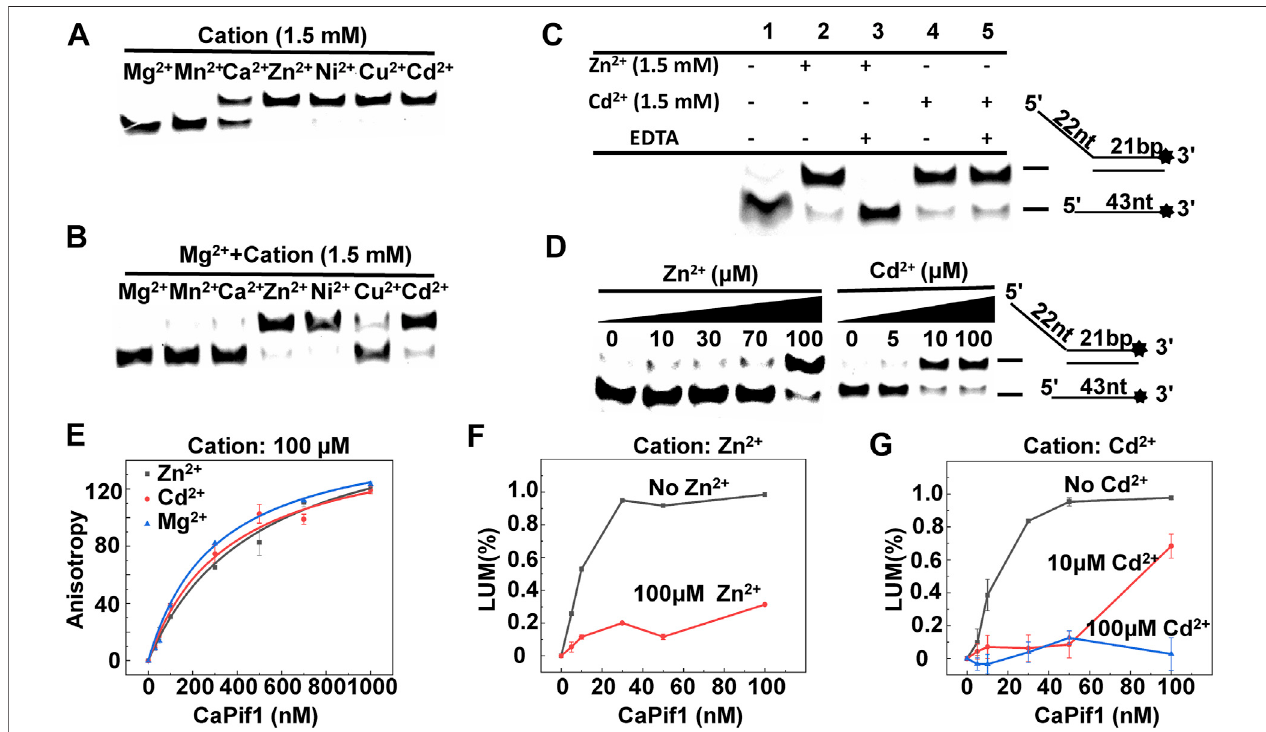
FIGURE 5 | The effects of metals on the unwinding activity of CaPif1. (A) CaPif1 (25 nM) was reacted with the DNA OhS22D21 (10 nM) in the presence of the indicateddivalentmetal(1.5 mM). (B) CaPif1wasincubatedwithindicateddivalentmetal(1.5 mM)andthenthesameconcentrationofMgCl 2 wasaddedseparately. (C) Lane 1: The control group containing 1.5 mM Mg 2+ without Zn 2+ and Cd 2+ ; Lane 2 and Lane 4: same method ( Figure 5B ); Lane 3 and Lane 5: CaPif1 separately incubated withZn 2+ (1.5 mM)orCd 2+ (1.5 mM)at 30 ° Cfor5 min, thenaddMgCl 2 witha fi nalconcentrationof1.5mM, incubate againat thesametemperaturefor 5 min, and fi nally add the 5 mM ofATPto startthe unwinding reaction. (D) Inhibit theunwinding activity of CaPif1at low concentrationsZn 2+ or Cd 2+ . Atotal of10 nM of fl uorescently labeled DNA substrate (OhS22D21)wastitratedwithincreasingconcentrationsofZn 2+ orCd 2+ .More details aredescribedinthe “ Materials and Methods ” section. (E) Polarizedlightisusedtodetectthein fl uenceofZn 2+ ,Mg 2+ ,andCd 2+